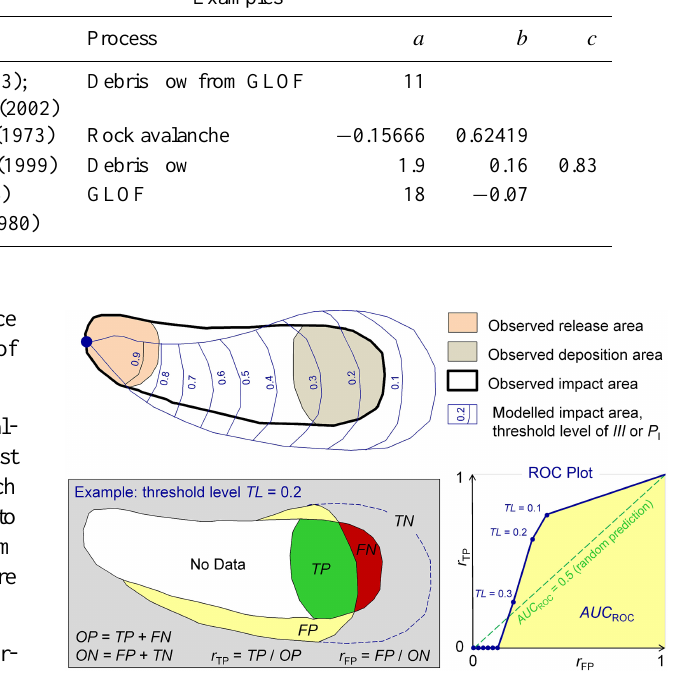
Table 3. Types of rules and relationships supported by r.randomwalk. ω T is angle of reach, L max is travel distance, V is volume of motion, Z is elevation loss, Q p is peak discharge at release, and v T is velocity at termination. ID